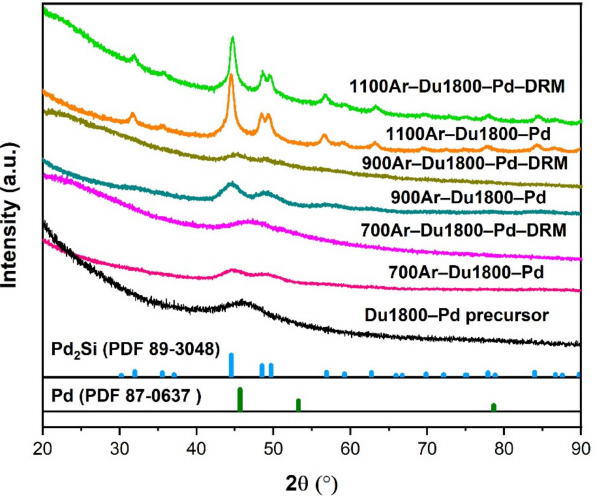
Figure 10. XRD patterns of the Du1800-Pd precursor and their derived Pd/SiOCN ceramic nanocom- posites before and after the DRM tests in a recirculating batch reactor.